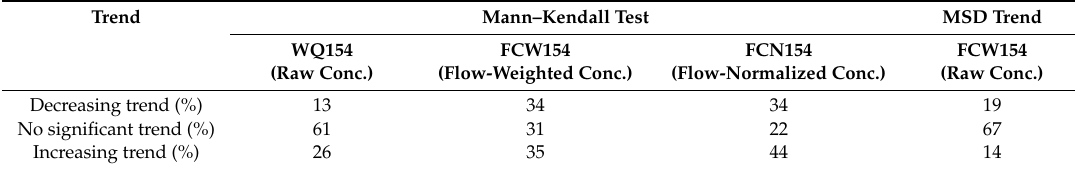
Table 4. Mann–Kendall trend analysis of annual nitrate concentration using raw WQ154, flow-adjusted FCW154 and FCN154 flow-normalized concentrations (random variation of flow removed) using the Mann–Kendall test for the period 1990–2017 (28 years) along with the calculated MSD (reporting